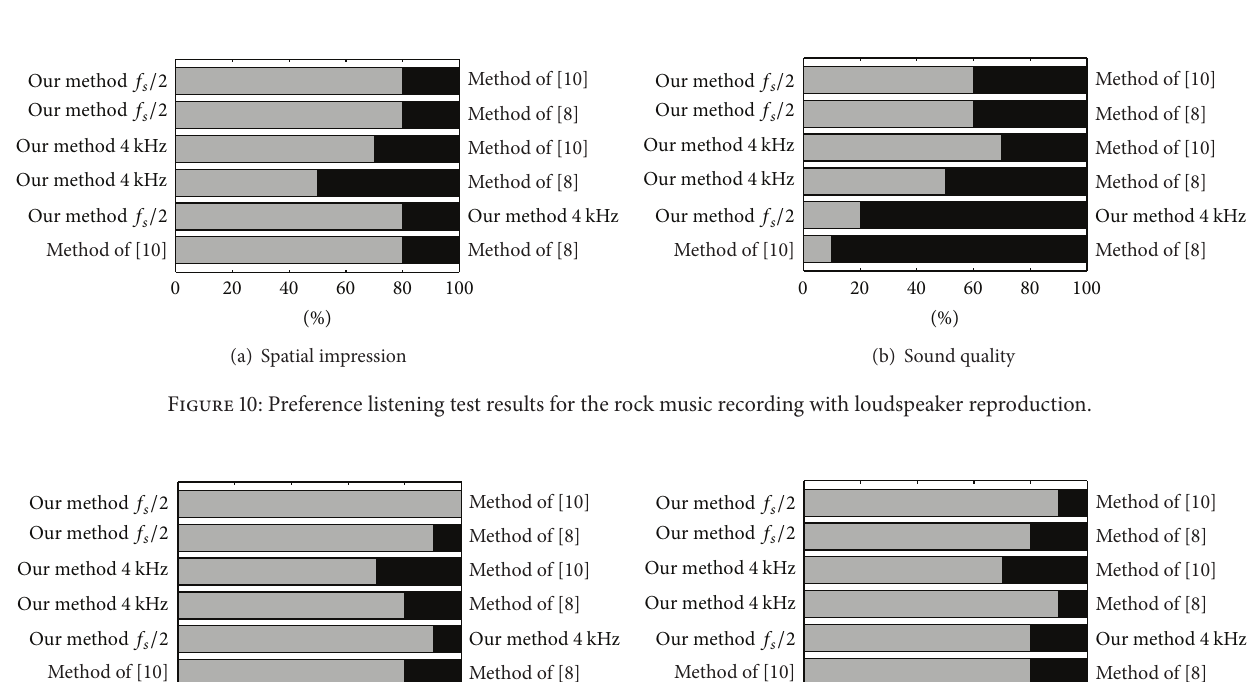
Figure 9: Preference listening test results for the classical music recording with loudspeaker reproduction.